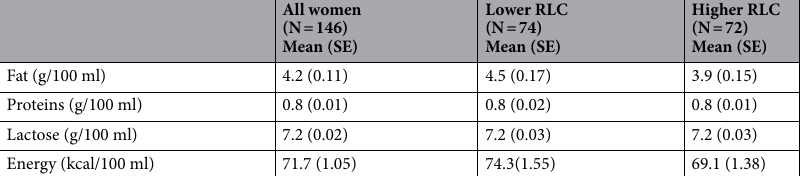
Table 2. Nutritional components of breast milk samples collected from mothers participating in the study and differences between lower and higher RLC (Recent Life Changes) score groups.